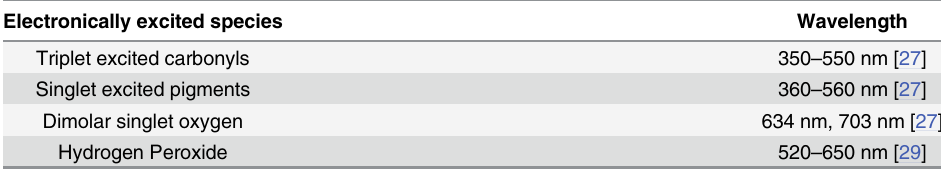
Table 5. Electronically excited species responsible for UPE.